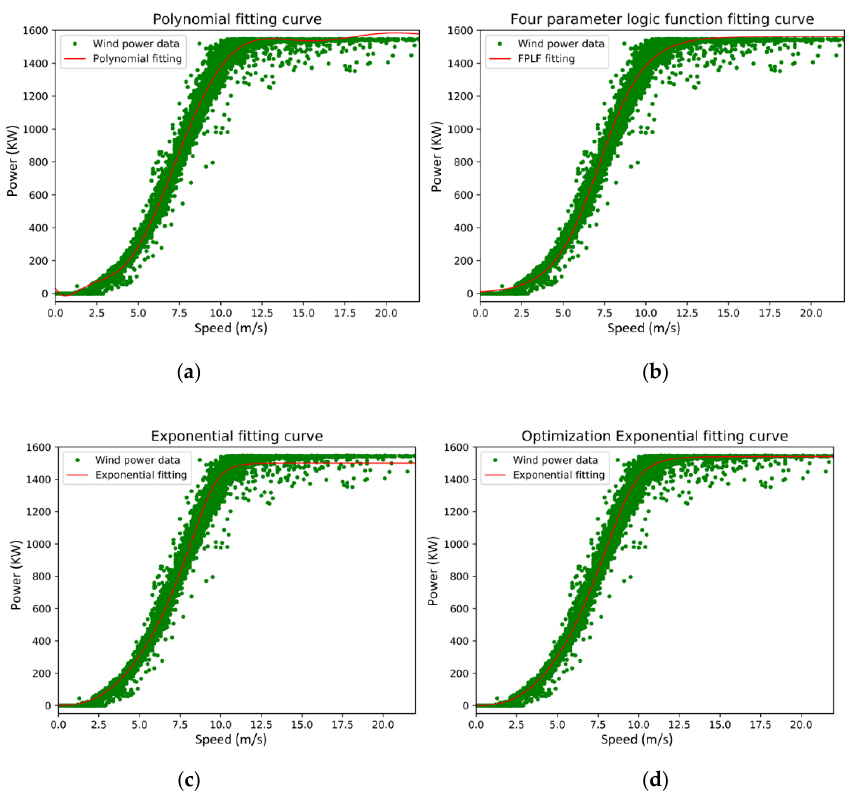
Figure 6. Comparison of wind power fitting curves (red curve). The green dots are 15-min mean wind speed and wind power pairs. The data period is 1 January 2019 to 1 November 2019. ( a ) Poly- nomial fitting curve; ( b ) four parameter logic function fitting curve; ( c ) exponential fitting curve; ( d ) optimization exponential fitting curve.